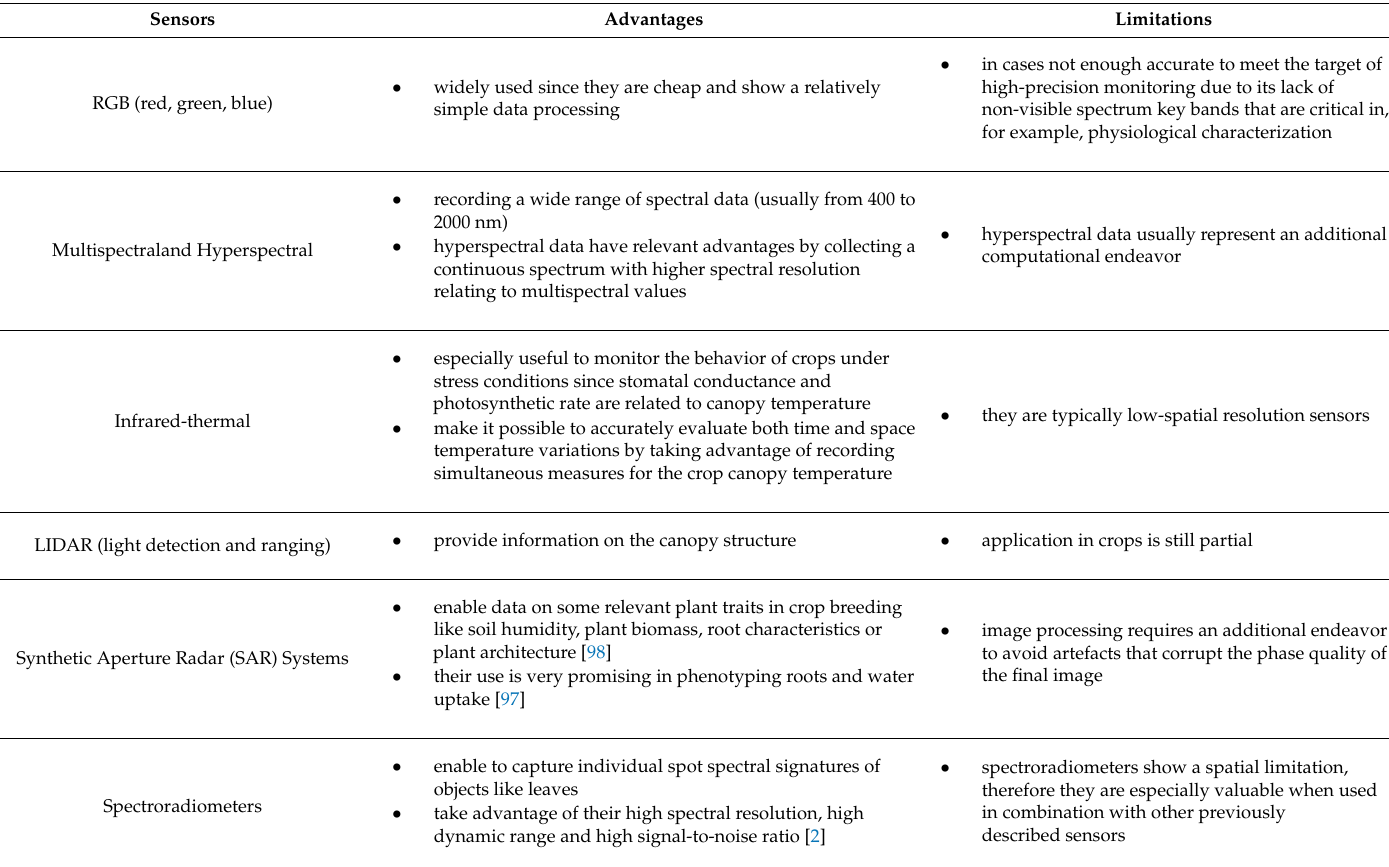
Table 1. Currently used sensors onboard high-throughput precision phenotyping (HTP) platforms, advantages and limitations for potential uses on the stay green (SG)